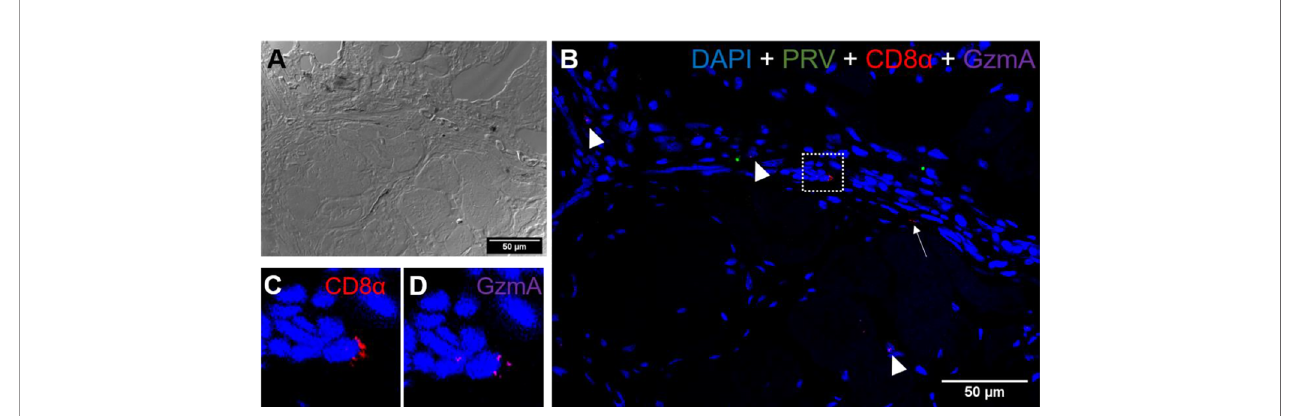
FIGURE 9 | Fluorescent in situ hybridization of PRV-1, CD8 a and GzmA in black focal changes. (A) phase contrast image showing cell structures with melanin accumulation. (B) Merged image showing presence of PRV-1 (green) infected cells with CD8 + cells (red) (arrows) and granzyme A (purple) in another cell population (arrowhead). Dotted rectangle showing co-expression of CD8 and GrzmA split in (C, D) . Nuclei DNA stained with DAPI (blue) Scale Bar = 50